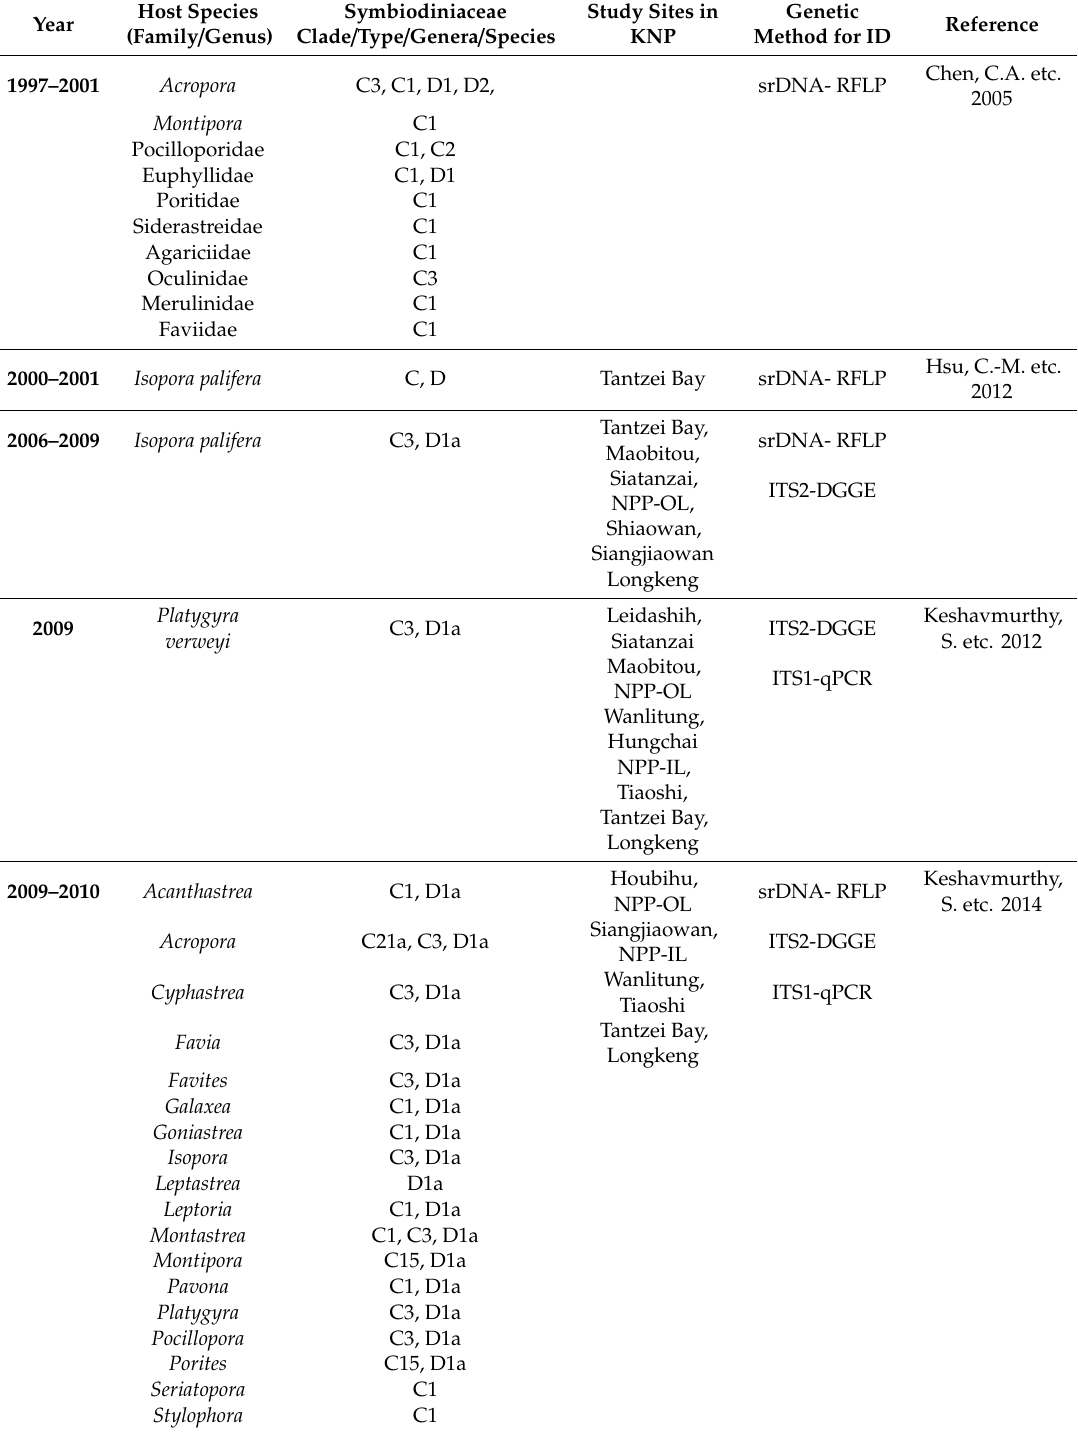
Table 4. Coral-Symbiodiniaceae associations in Kenting National Park through time analyzed using more sensitive over time. Until 2010 all data are shown by old taxonomy used for Symbiodiniaceae. C = Cladocopium spp. (previously clade C), D = Durusdinium spp. (previously clade